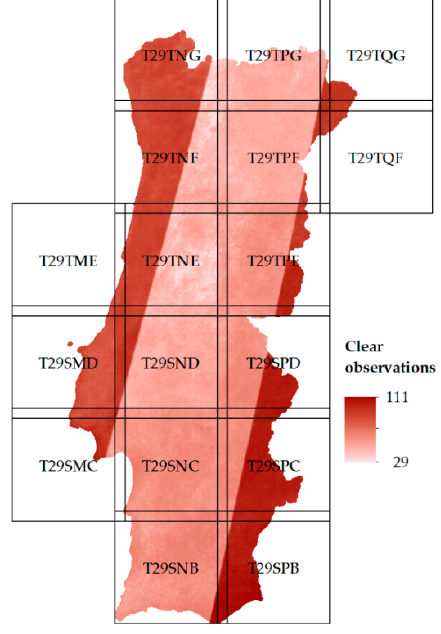
Figure 1. Sentinel-2 data used over mainland Portugal. Black outlines represent the image tiles. The